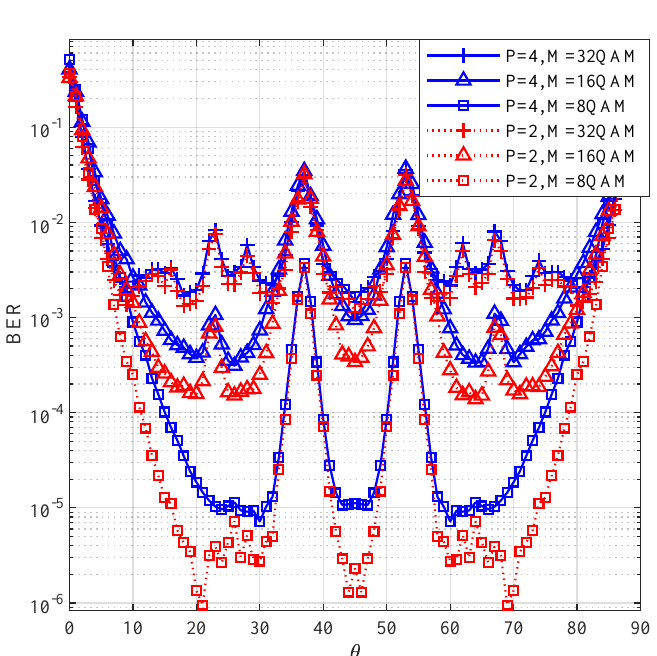
Figure 2. Optimized rotation angle for PCQSM with N t = 8, N r =